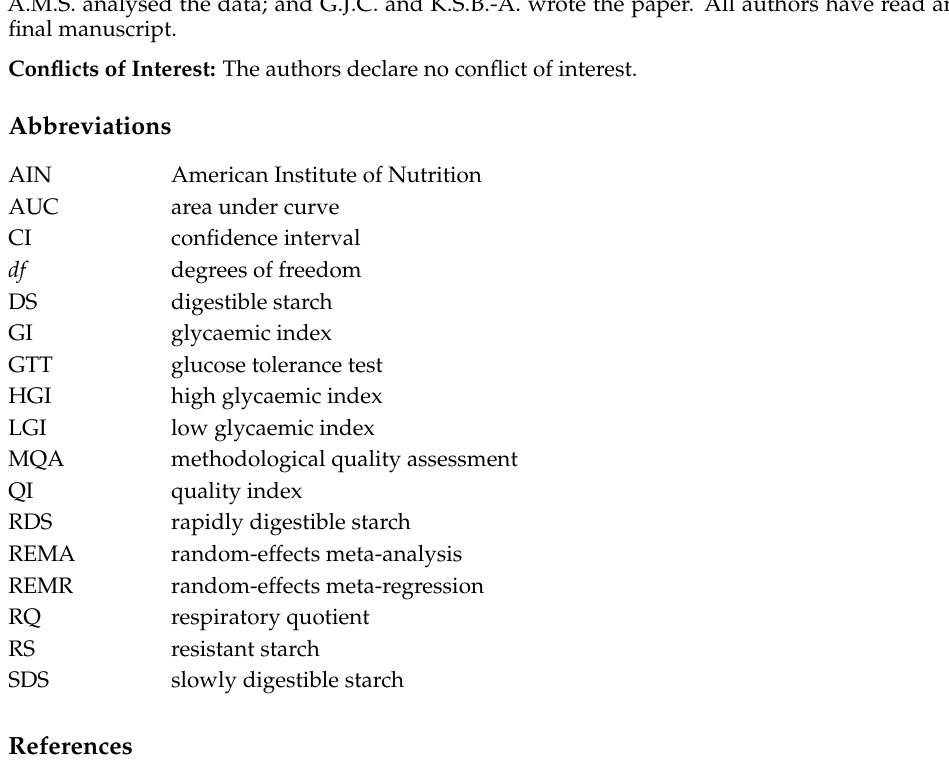
Table S1: Raw data for meta-analysis, Text S1: R code for meta-analysis, Figure S1: Funnel plot of effect